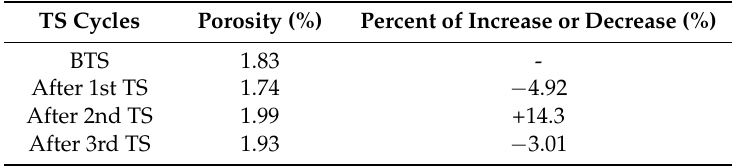
Table 4. Porosity results of core sample SH#5 before and after thermal shocking.